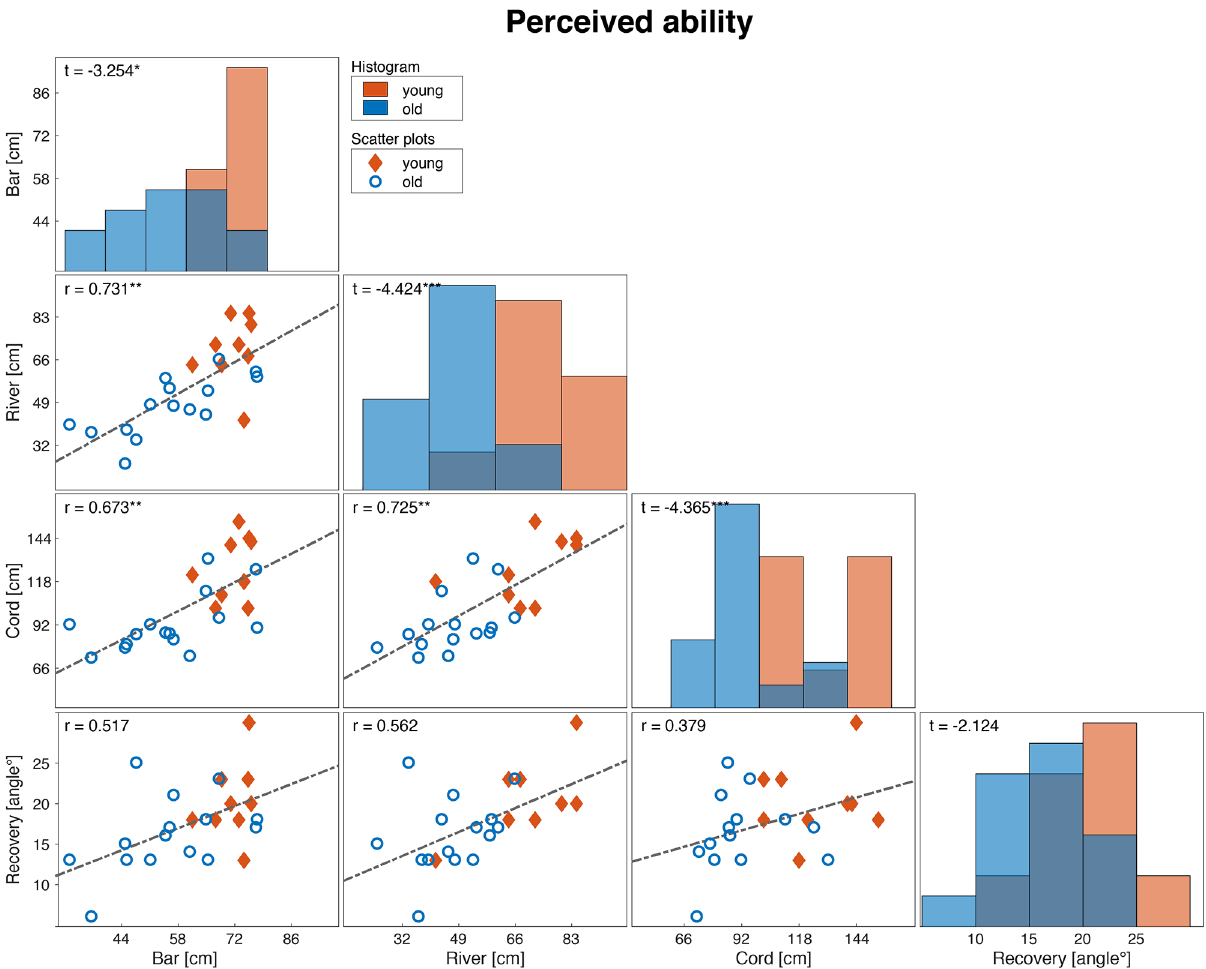
Fig 3. Distribution and correlation matrix of the perceived ability measuresof different tasks. The diagonalpanels(histograms) show the distributionof the four perceivedability measuresof both the age groups. The off-diagonal panels (scatter plots) show correlations betweenperceivedability measures of different tasks. Diamondsrepresentyoung adults and circles represent older adults. Corresponding correlationcoefficients and t-tests (i.e., testing the differencesbetween youngand older adults) are indicatedin the top-left corner of each panel ( * :p < 0.05, ** :p < 0.01, *** :p < 0.001).